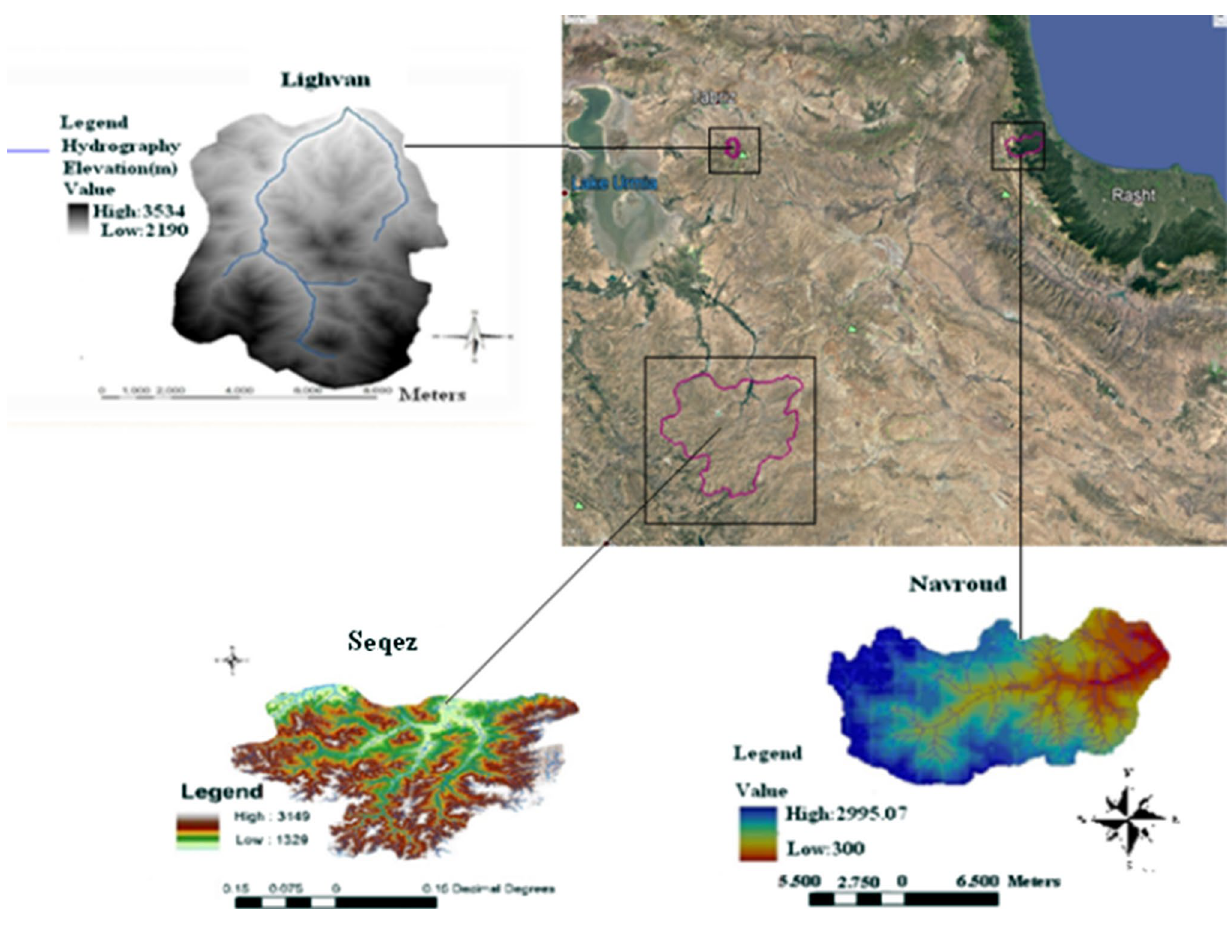
Fig. 1 Location of the study areas in Iran